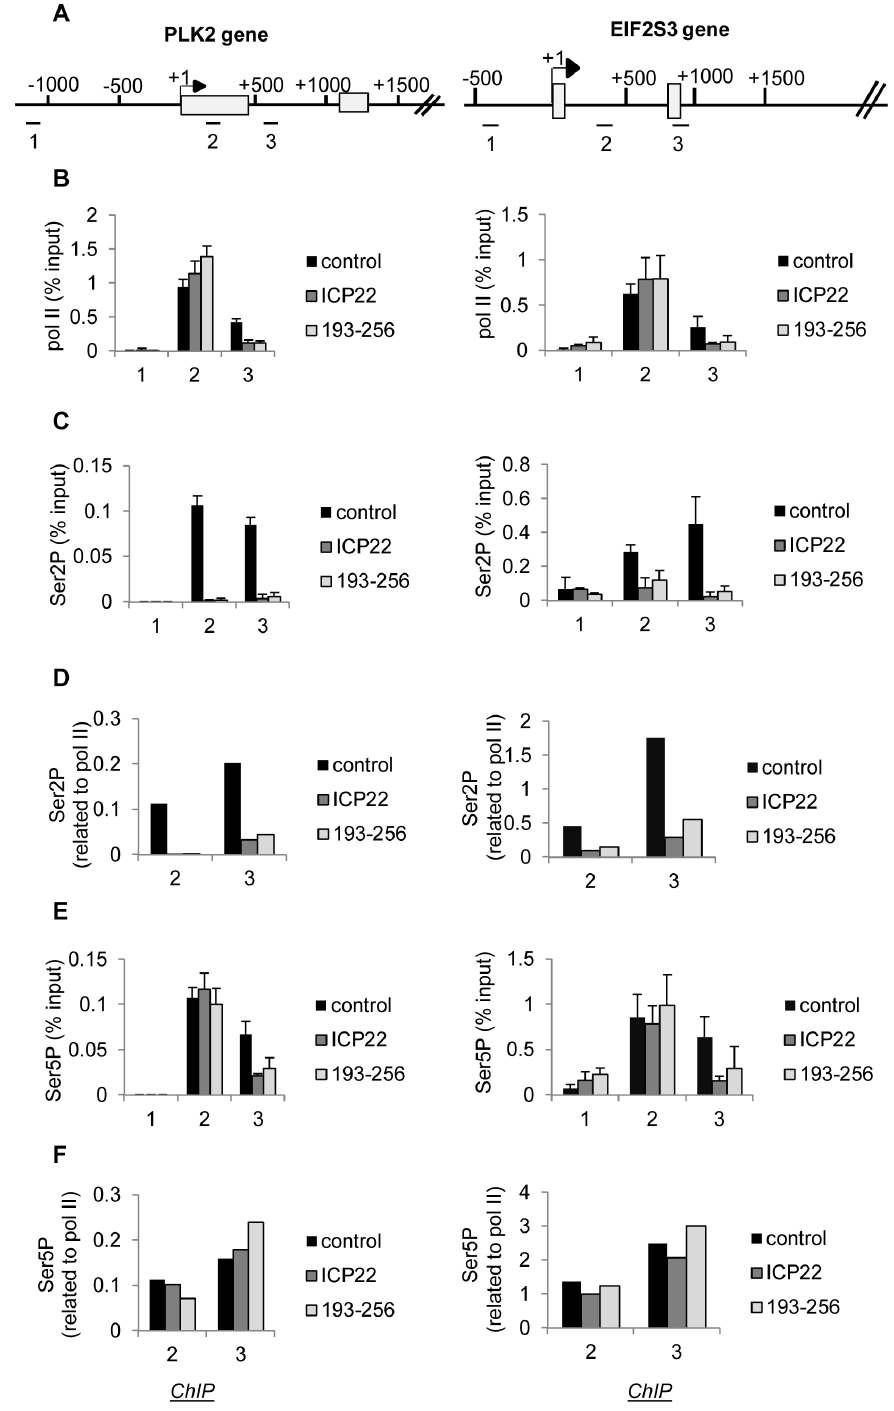
Figure 3. Ectopic expression of ICP22 or the 193–256 subdomain causes loss of Ser2 phosphorylation from pol II transcribing host cell protein-coding genes. ( A ) Diagrams of the PLK2 and EIF2S3 genes, with the position of chromatin immunoprecipitation (ChIP) primer pairs indicated. ( B ), ( C ), ( E ) The results of ChIP analysis using the antibodies indicated on the left after transfection of vectors expressing the Myc-tagged proteins indicated. ( D ), ( F ) The ratio of the CTD modification to pol II as indicated at the